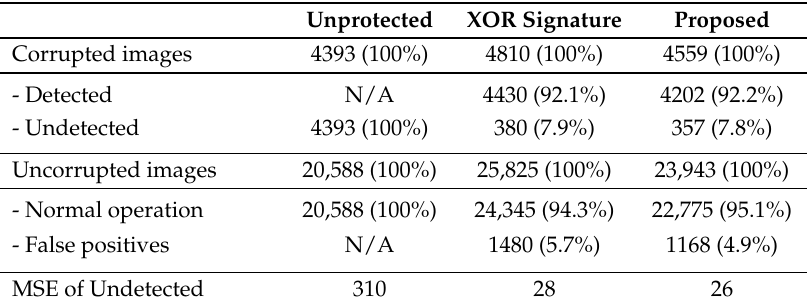
Table 4. Error Detection Report (Series).